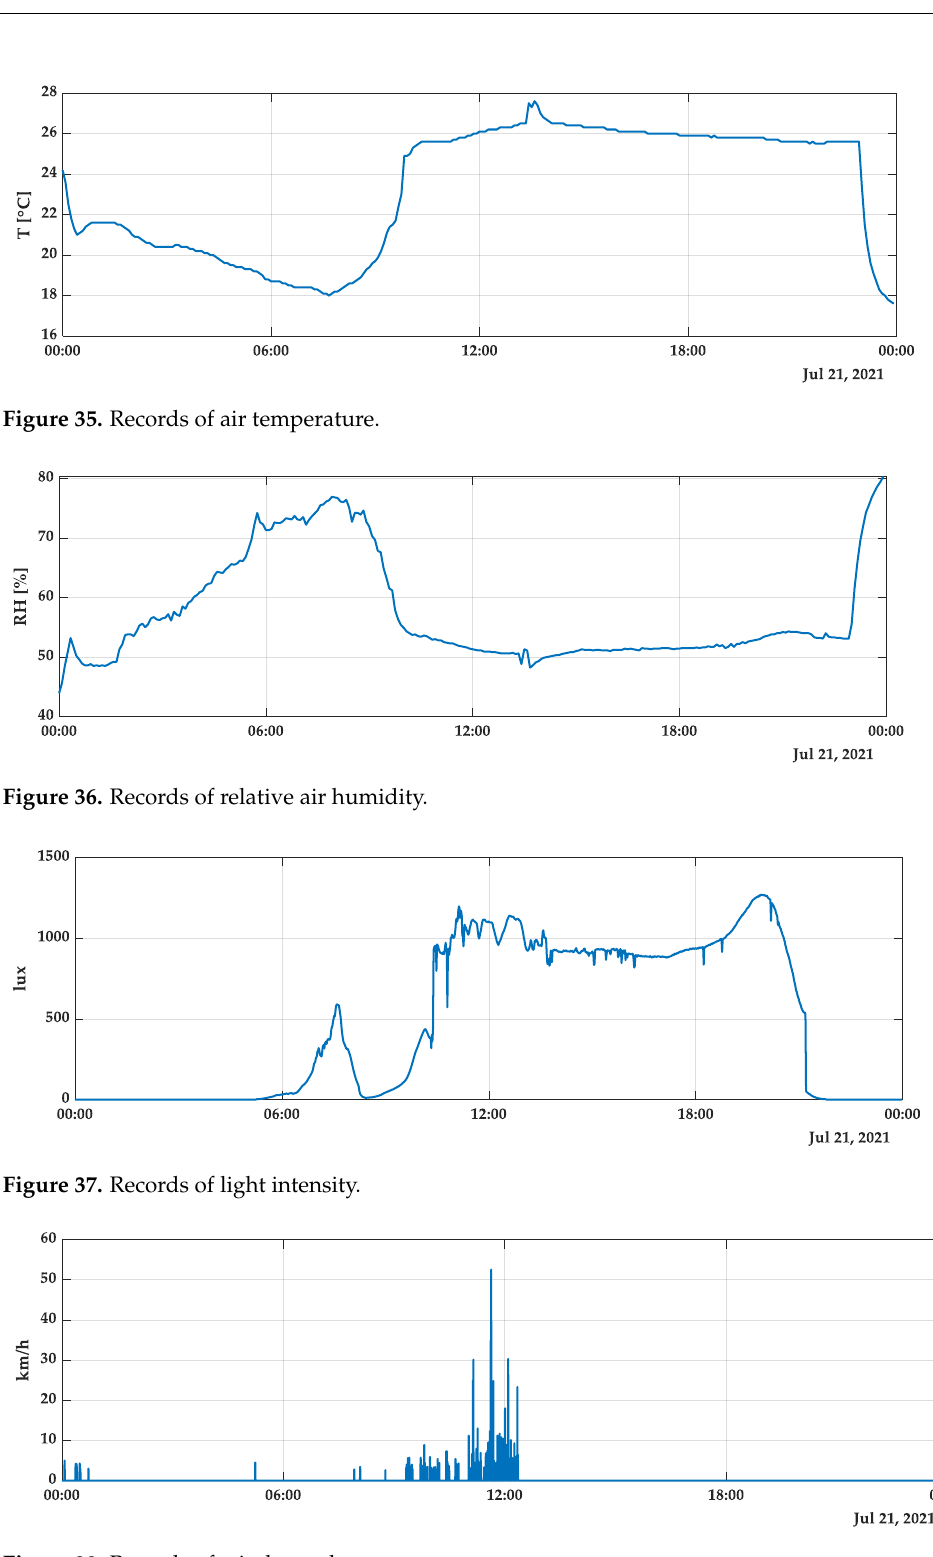
Figure 38. Records of wind